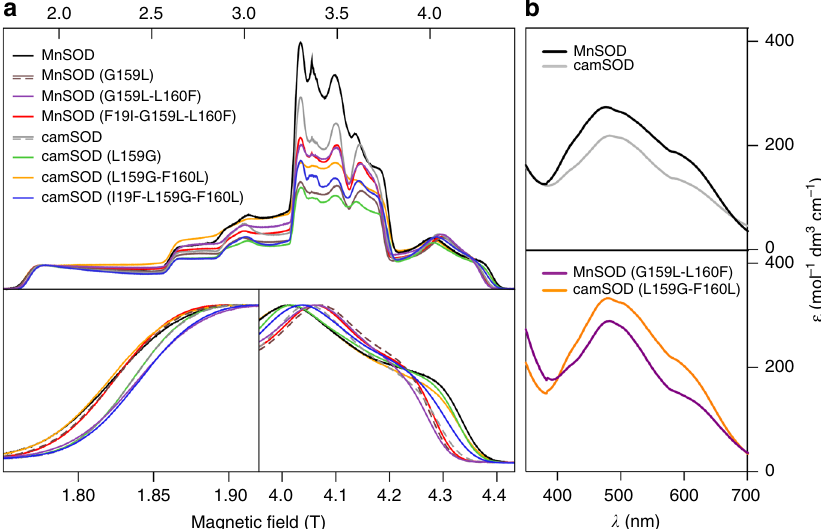
Fig. 3 Differences in electronic structure and auto-oxidation of the SODs. a The 94 GHz Mn(II) fi eld-swept echo HFEPR spectra (upper panel) of each of the dithionite-reduced, manganese-loaded forms of the S. aureus wild type and variant SODs (labeled in the color key, top left), acquired at 5 – 6 K ( n = 1). The lower panels show expanded views of the (left) lower and (right) upper fi eld shoulders, respectively, which are indicated by arrows in the upper panel. SOD mutations gave rise to detectable differences in the enzymes ’ HFEPR spectra and their ZFI (Supplementary Figs. 6 – 7 and Supplementary Table 6), demonstrating altered electronic structure and redox properties caused by the mutations. b UV/visible absorption spectra of the manganese-loaded forms of the (upper) wild type and (lower) double mutant variants of MnSOD (black and purple, respectively) and camSOD (gray and orange, respectively). MnSOD exhibits greater auto-oxidation at rest than camSOD, illustrated by increased absorbance of Mn(III) at ~480 nm, a trend which is reversed in the double mutant variants that also exhibited reciprocal changes in metal speci fi city (Table 1). All samples (800 µ M) were equilibrated with ambient aerobic conditions in 100 mM phosphate buffer, pH 7.5, 100 mM KCl, 1 mM EDTA before spectra were acquired. Spectra were collected on independent biological replicates ( n = 2), mathematically converted to extinction coef fi cient ( ε ) using the Beer-Lambert law, and a representative spectrum is shown for each